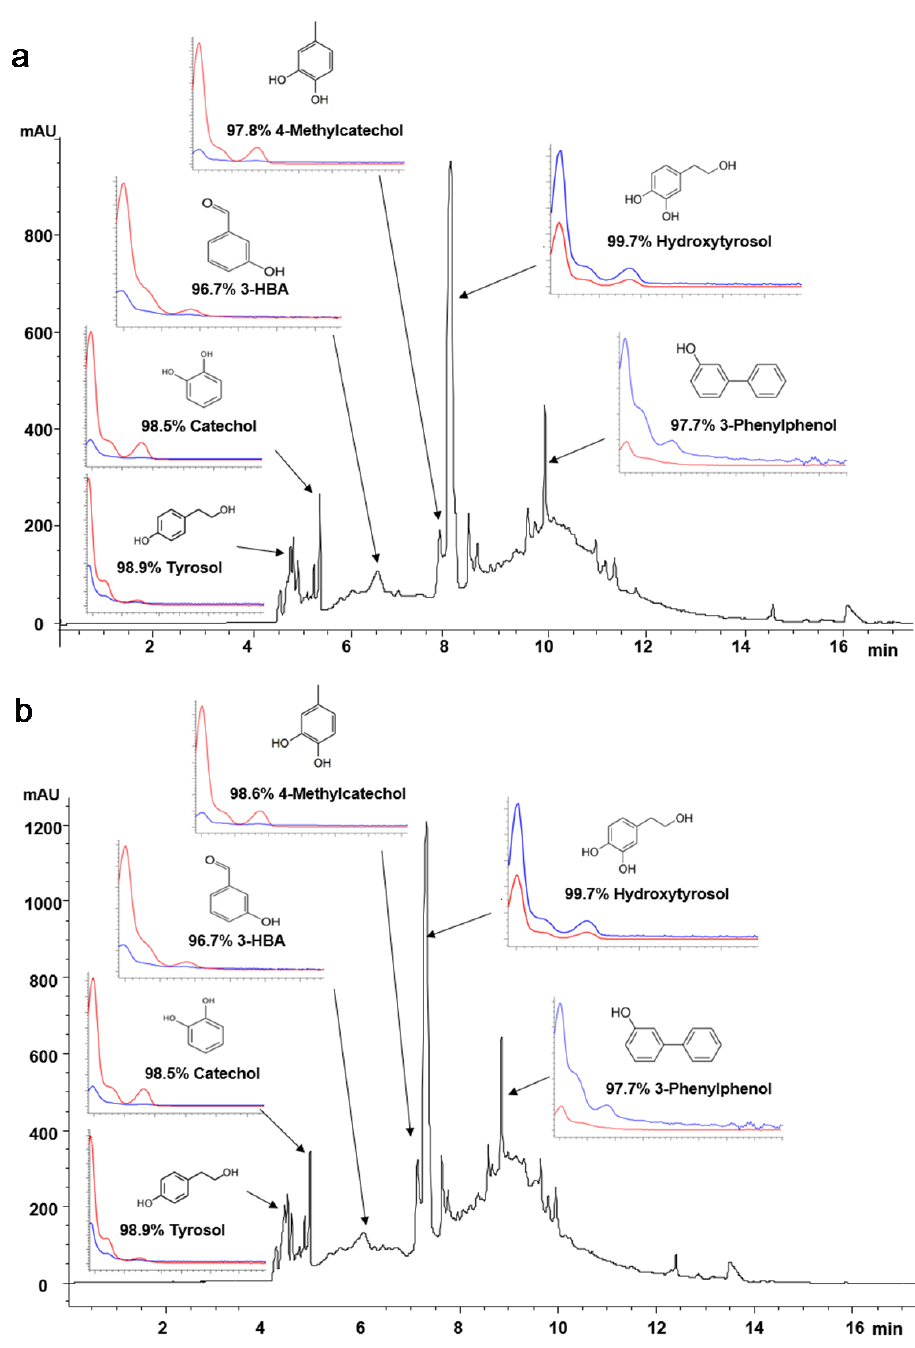
Figure 4. Electropherograms at 200 nm of the water–acetone extract obtained by ( a ) bath- and ( b ) probe-type ultrasound-assisted extraction of exhausted olive pomace in the best obtained